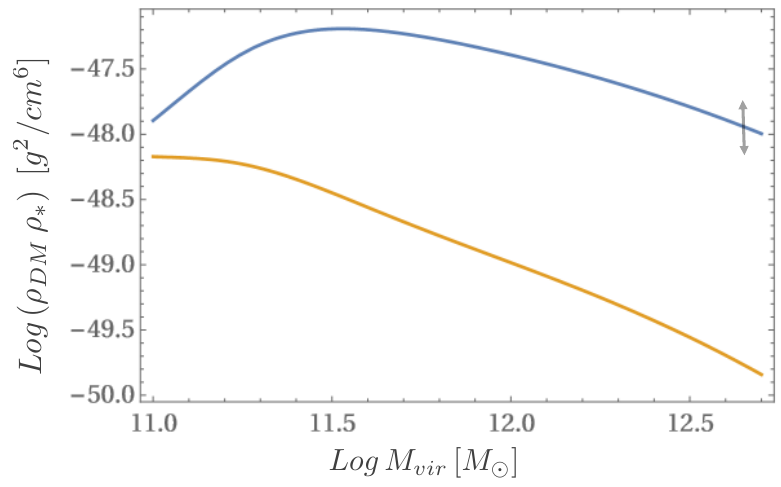
Figure 3. log K C ( r 0 ) as a function of log M vir ( blue line ). K SA ( r 0 ) is also shown ( orange line ).